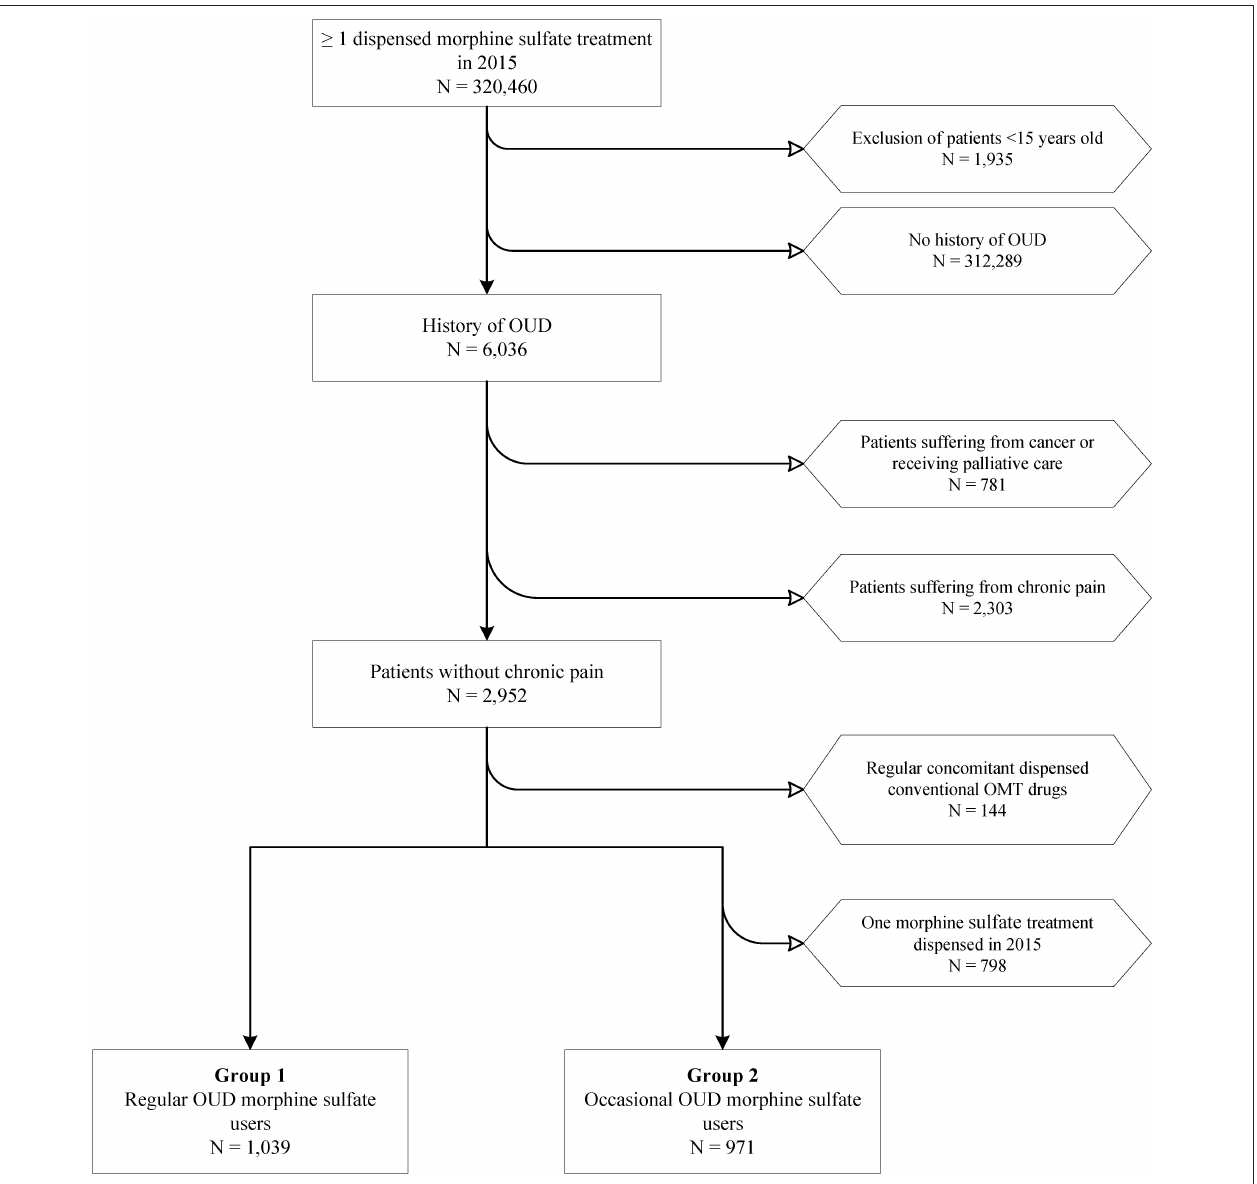
FIGURE 1 | Flow chart of patient selection for interest groups. OUD, opioid use disorder; OMT, opioid maintenance